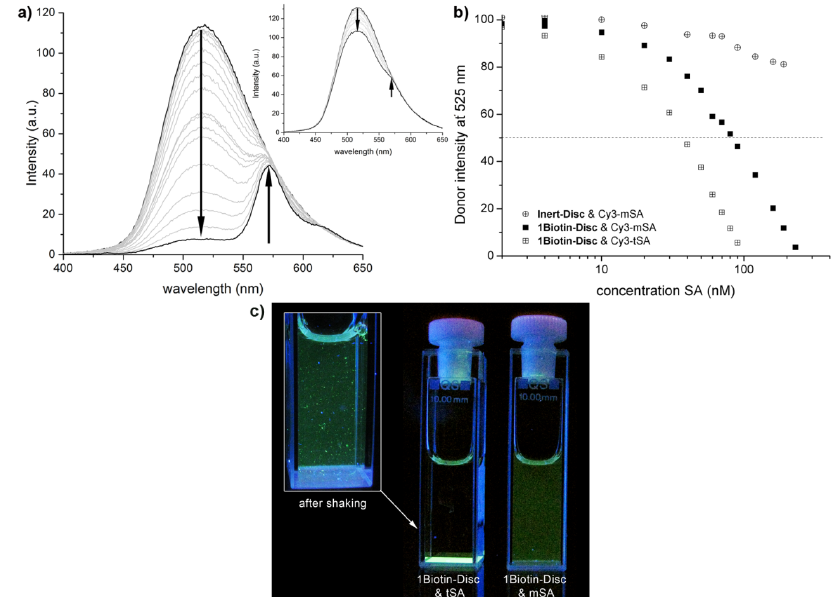
Figure 2. ( a ) Emission spectra of the titration of monovalent Cy3-labeled streptavidin (Cy3-mSA, 0 nM–270 nM) to 1Biotin-Disc (1 µM). Inset: Emission spectra of the titration of monovalent Cy3-labeled streptavidin (0 nM–270 nM) to Inert-Disc (1 µM); ( b ) Normalized decrease in disc intensity at 525 nm upon addition of Cy3-mSA or Cy3-tSA to 1Biotin-Disc and Inert-Disc (both 1 µM); Dashed line represents the intensity, where half of the donor intensity is quenched; ( c ) Photography of cuvettes under UV-light three days after Förster resonance energy transfer (FRET)